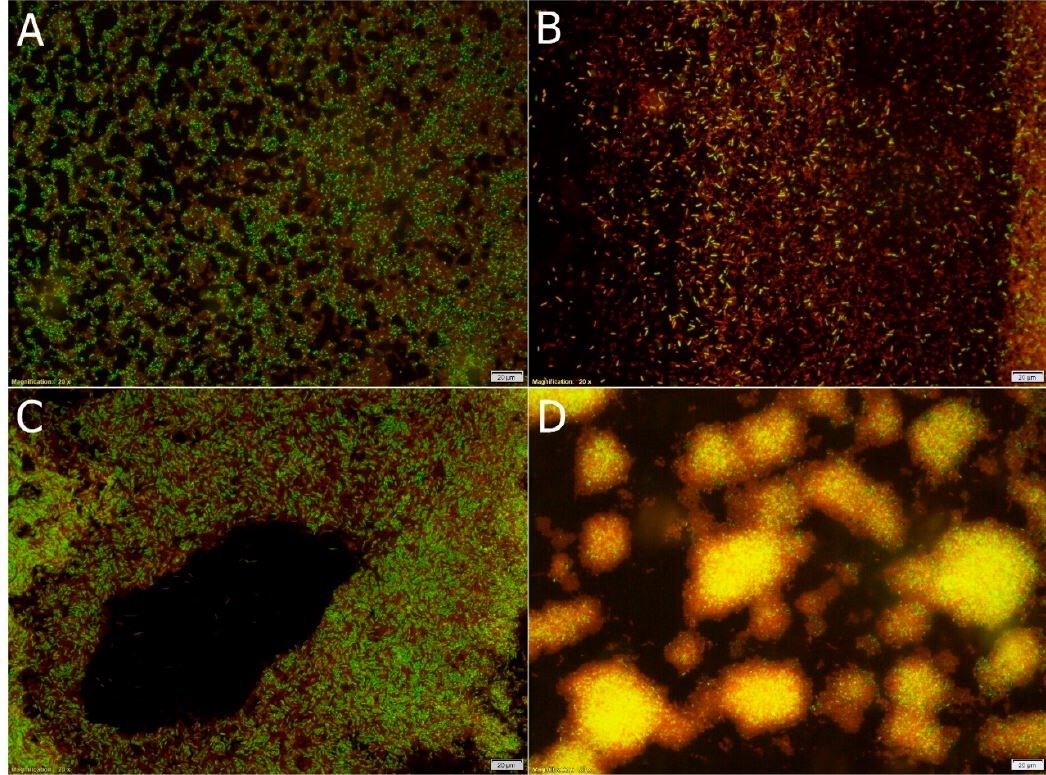
Figure 3. Microscopic observation of As. bogorensis ISD2 biofilms formed after 3-days-incubation ( A , B ) and 6-days-incubation ( C , D ) in minimal medium ( A , C ) and medium with 10% ( v / v ) M. piperita L. ( B , D ).